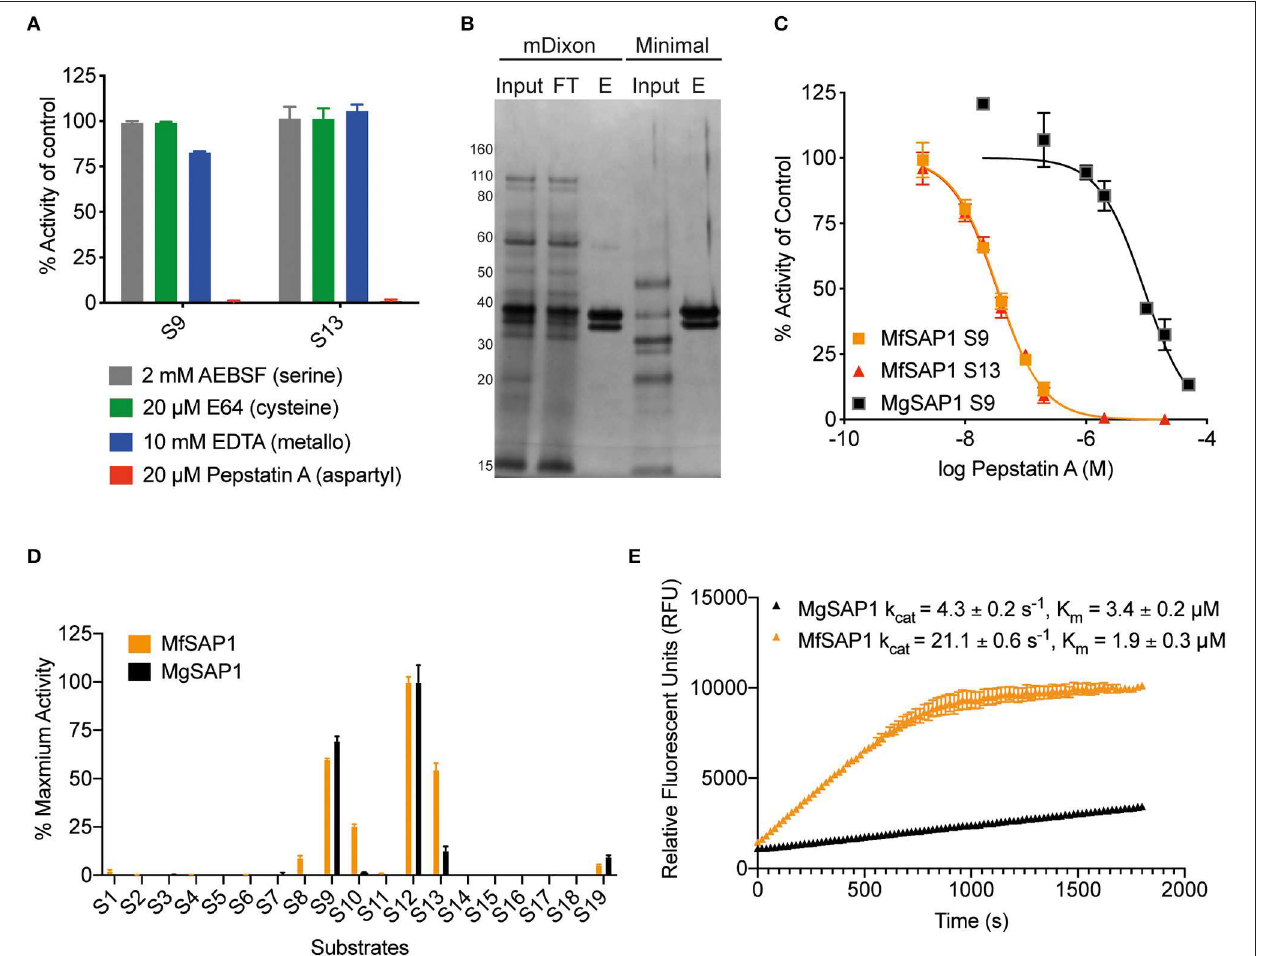
FIGURE 2 | Identification of the major aspartyl protease MfSAP1 in M. furfur and comparison with its M. globosa homolog MgSAP1. (A) M. furfur extracellular media was treated with each protease inhibitor and the remaining protease activity was assessed using S9 and S13. (B) Silver stain of the extracellular media (input), the enriched elute (E) and the flow-through (FT) from the pepstatin A-agarose affinity purification of the secreted proteases in M. furfur culture grown in mDixon and minimal media. (C) Inhibition curves of the enriched proteases MfSAP1 and MgSAP1 against the aspartyl protease inhibitor pepstatin A. (D) Comparison of the substrate cleavage preferences of MfSAP1 and MgSAP1 for the quenched substrates S1-S19. Protease activities were normalized to the maximum activity of the panel (S12) in each enzyme. (E) Kinetic parameters of enriched MfSAP1 and MgSAP1 for cleavage of substrate S12. A representative plot at 20 µ M of S12 is shown for both enzymes. The Michaelis-Menten plot for MfSAP1 is included in Supplementary Figure 1 . The data for MgSAP1 is previously published in Li et al. (2018). Error bars represent standard deviation for n =